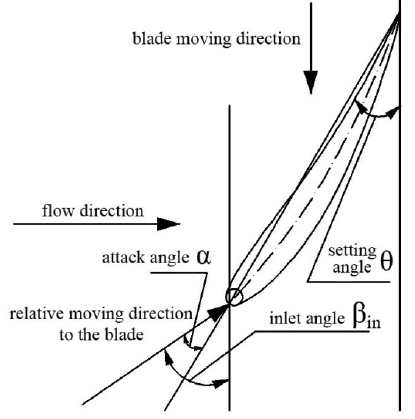
Figure 8. The position of the attack angle.